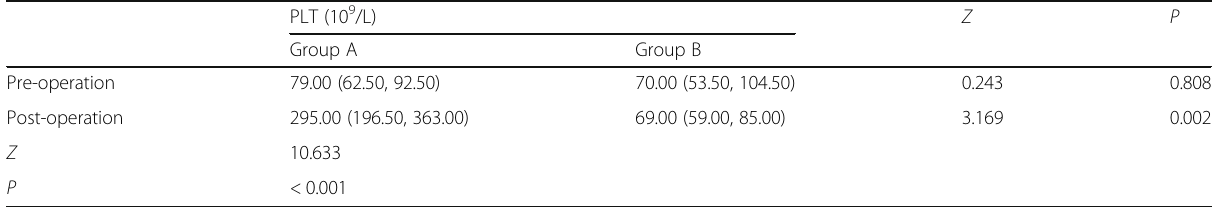
Table 1 Platelet count before and at 6 months after Rex-bypass shunt operation in Group A and Group B